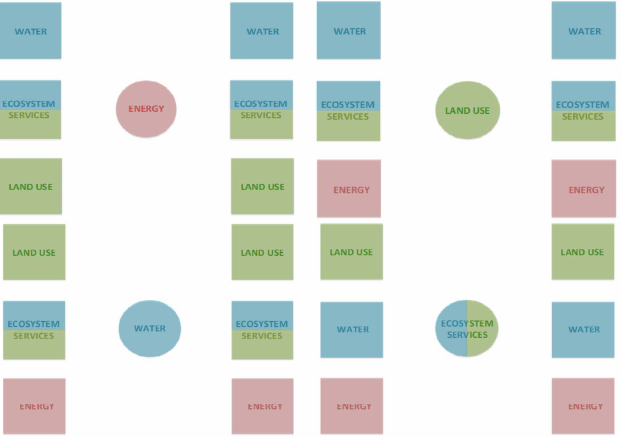
Figure A1. Sector-centered graphs used to facilitate discussion at the workshop